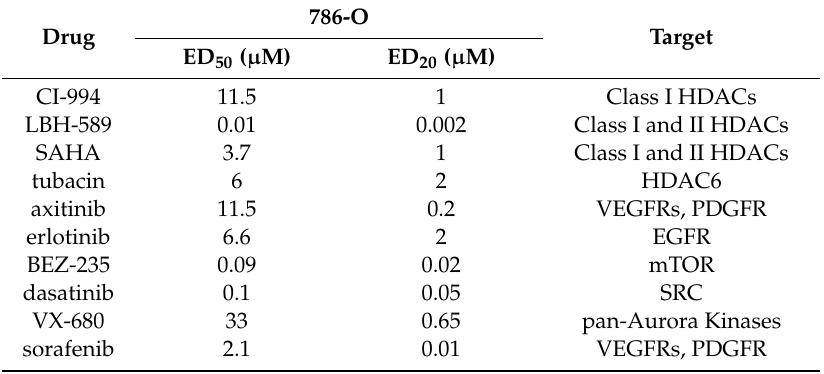
Table 1. Initial drug set used in the Therapeutically Guided Multidrug Optimization (TGMO) screen. Based on dose-response curves generated for each compound the ED 20 dose was selected. Cell